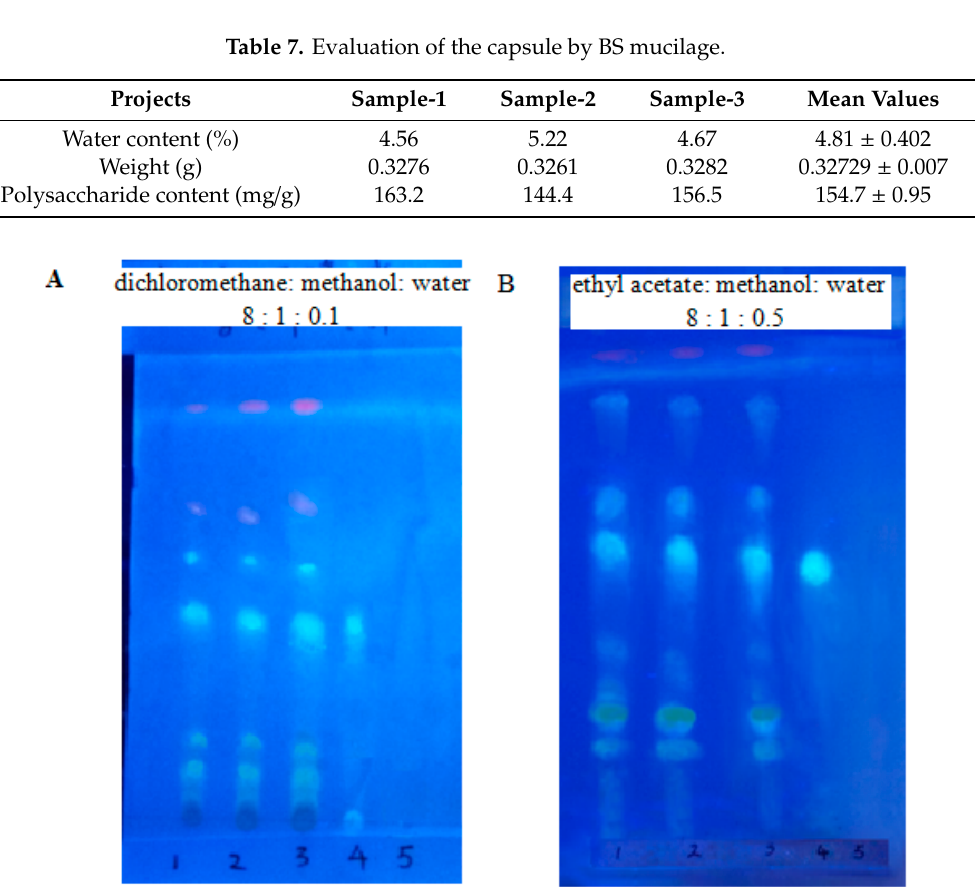
Figure 3. Isolation of polysaccharide from capsules made by BS mucilage by thin layer chromatography and its visualization under far UV light. ( A ) TLC image with dichloromethane:methanol:water = 8:1:0.1 as the developing solvent; ( B ) TLC image with ethyl acetate:methanol:water = 8:1:0.5 as the developing agent. 1–3, 4 and 5 refer to BS mucilage capsule samples, quercetin reference and